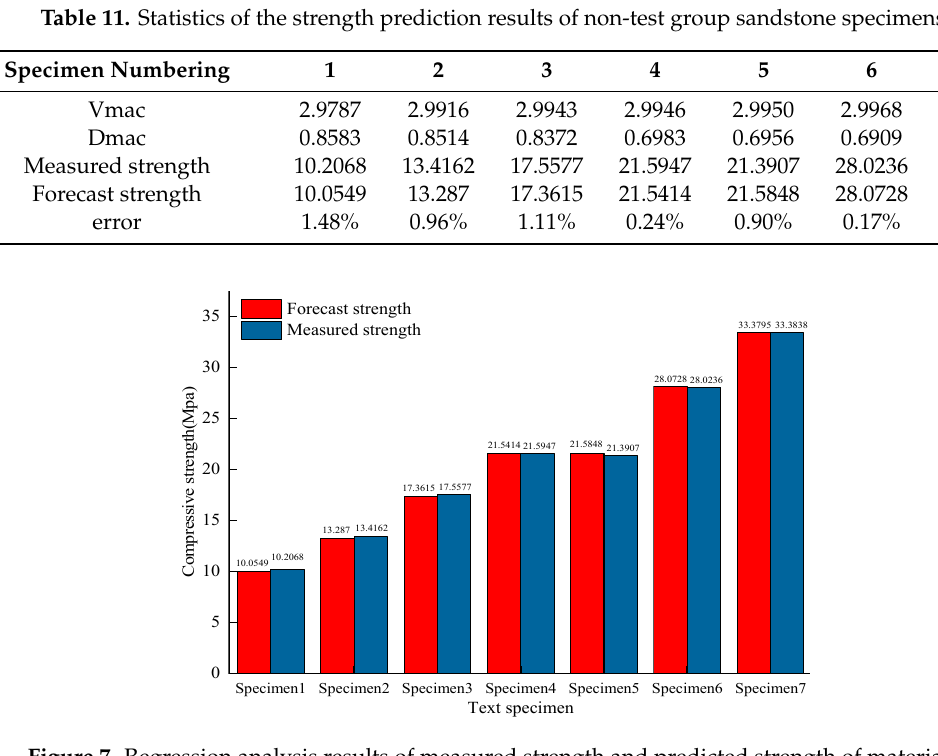
Figure 7. Regression analysis results of measured strength and predicted strength of materials.